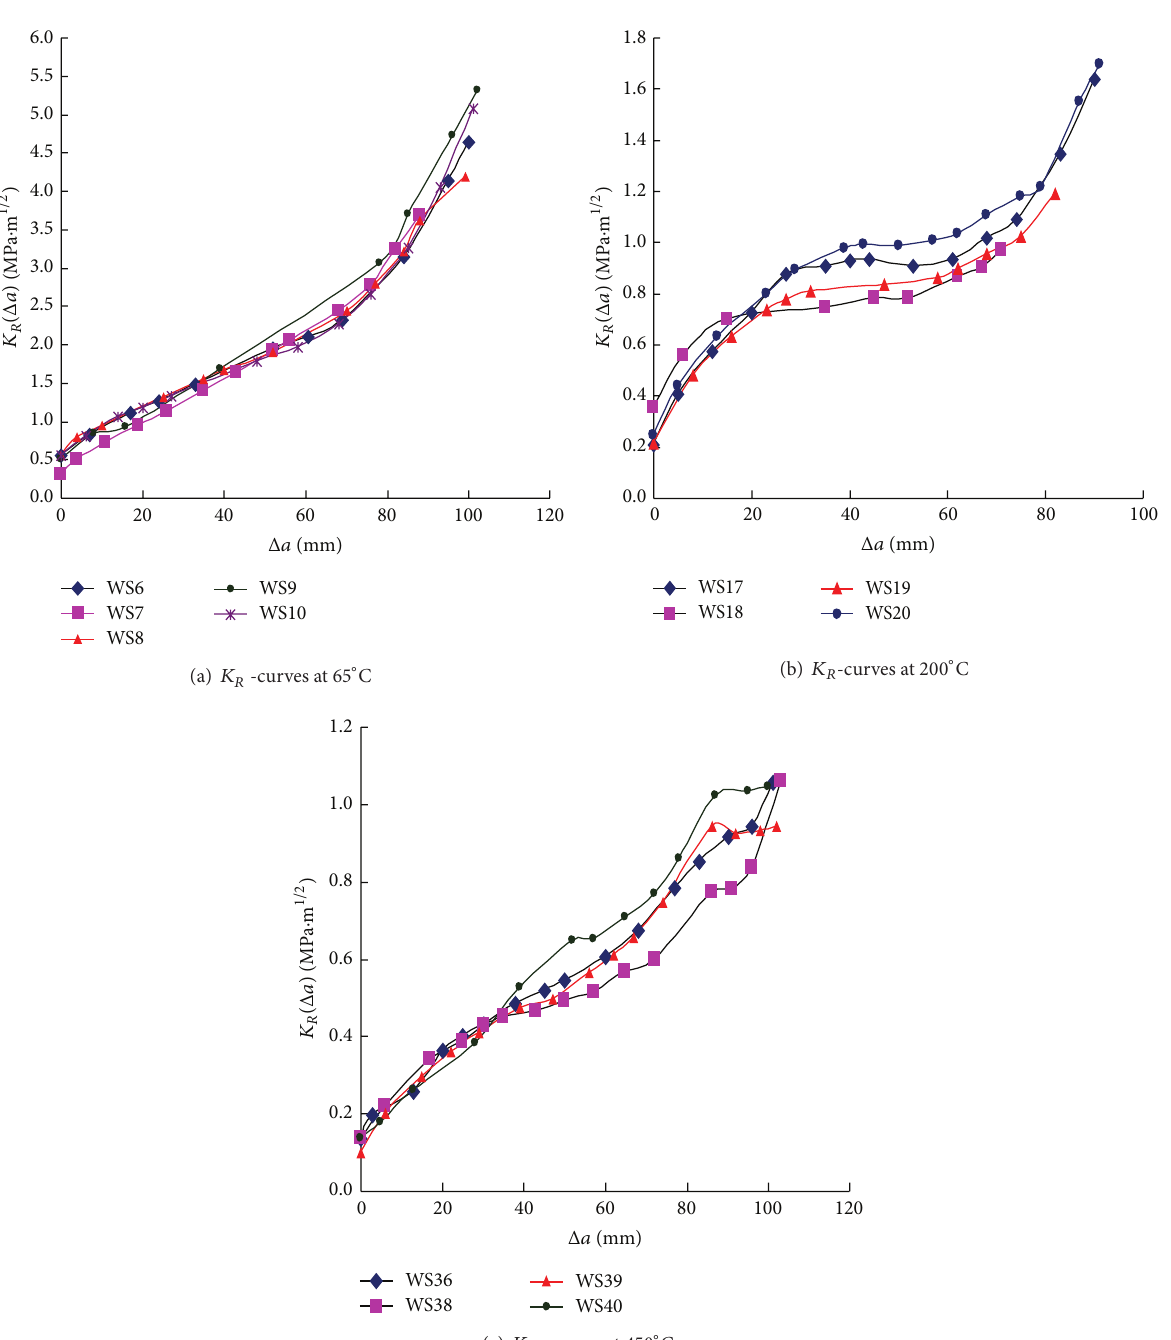
Figure 9: 𝐾 𝑅 -curves with crack extension length of various temperatures.